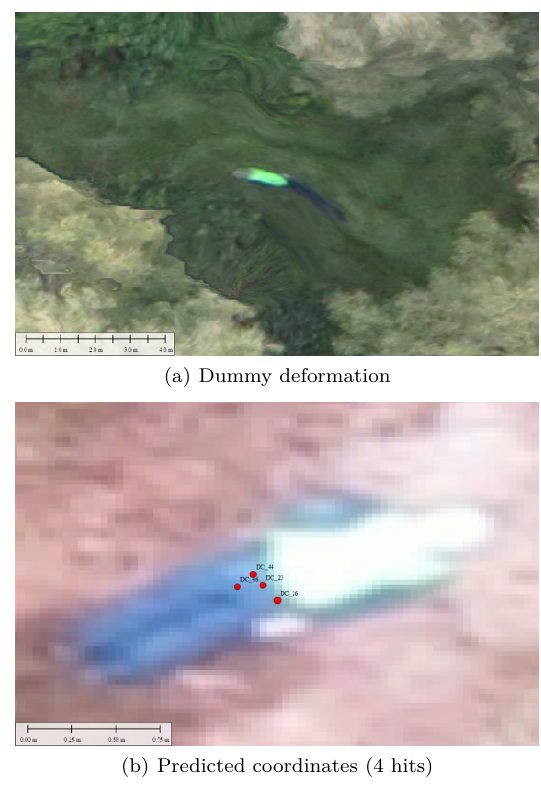
Figure 11. Orthophoto zoom on dummies